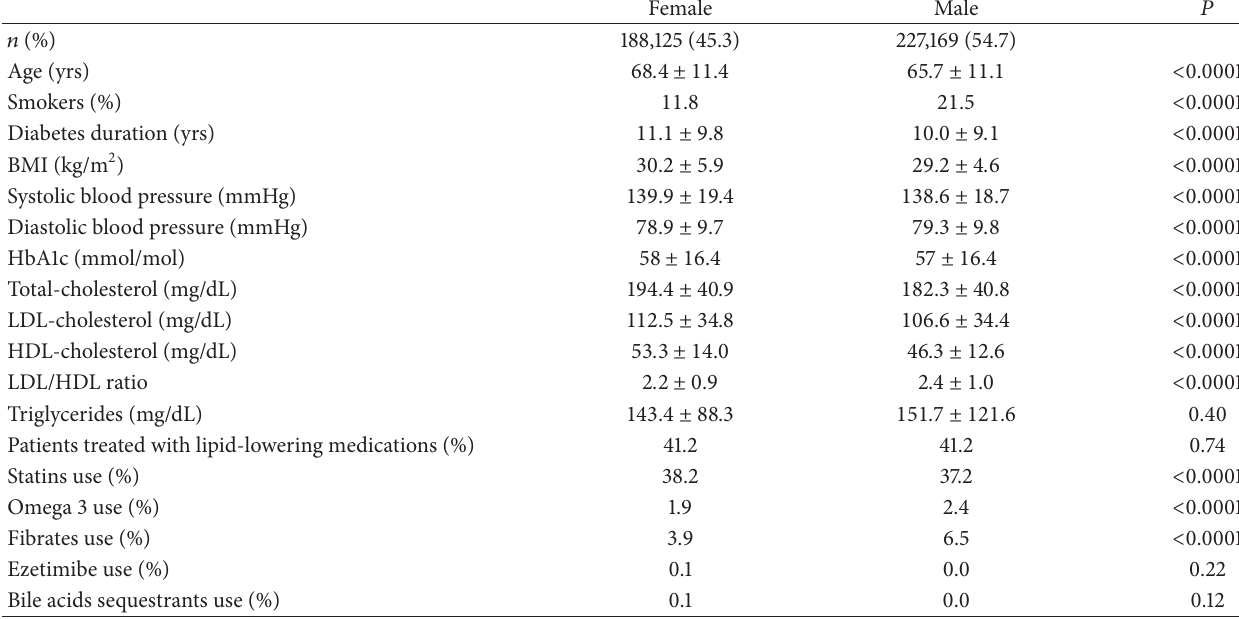
Table 1: Clinical characteristics of T2DM outpatients according to